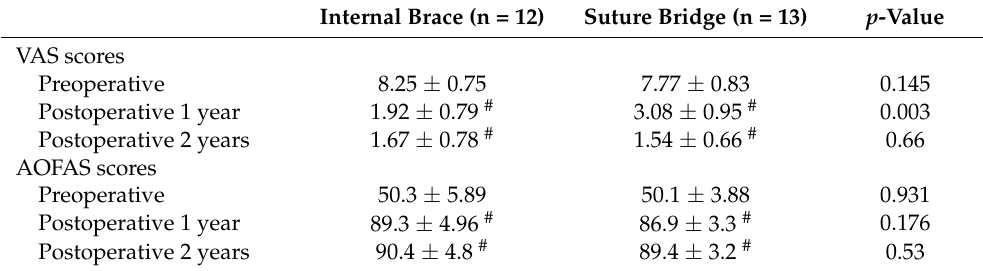
Table 2. Assessment of pain and ankle function.